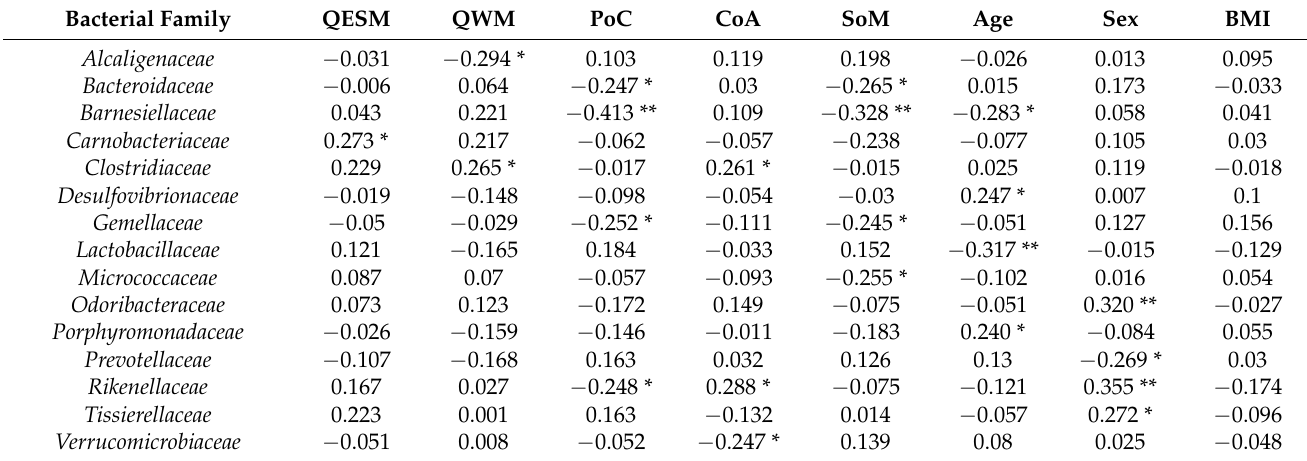
Table 3. Association between bacterial family, cognition and anthropometric